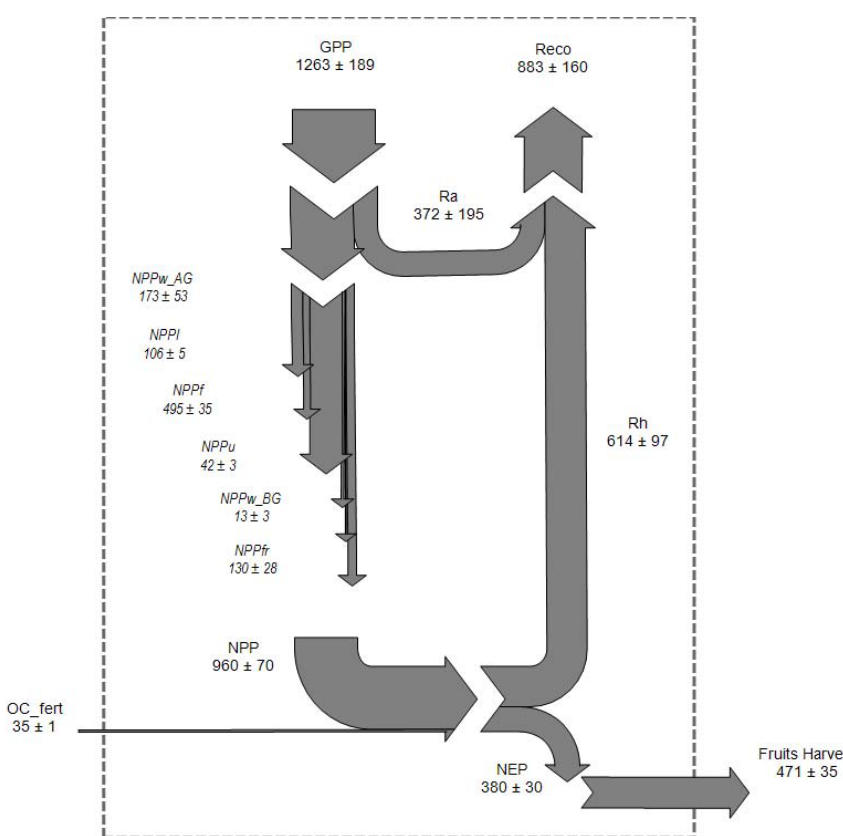
Fig. 7. Sankey plot of the carbon cycle of the studied agro-ecosystem for the year 2010. Data are in g of Cm 2 yr − 1 for each component of the C cycle. Arrows’ width reflects the flux size. GPP = gross primary production; Ra = autotrophic respiration; Reco = ecosystem respira- tion; Rh = heterotrophic respiration; NPP = net primary productivity; NPP w AG = aboveground wood NPP; NPP l = leaf NPP; NPP f = fruit NPP; NPP u = understory NPP; NPP w BG = belowground wood NPP; NPP fr = fine roots NPP; OC fert = organic carbon content of fertilizer; NEP = net ecosystem productivity; Fruit Harvest = fruit production exported from the